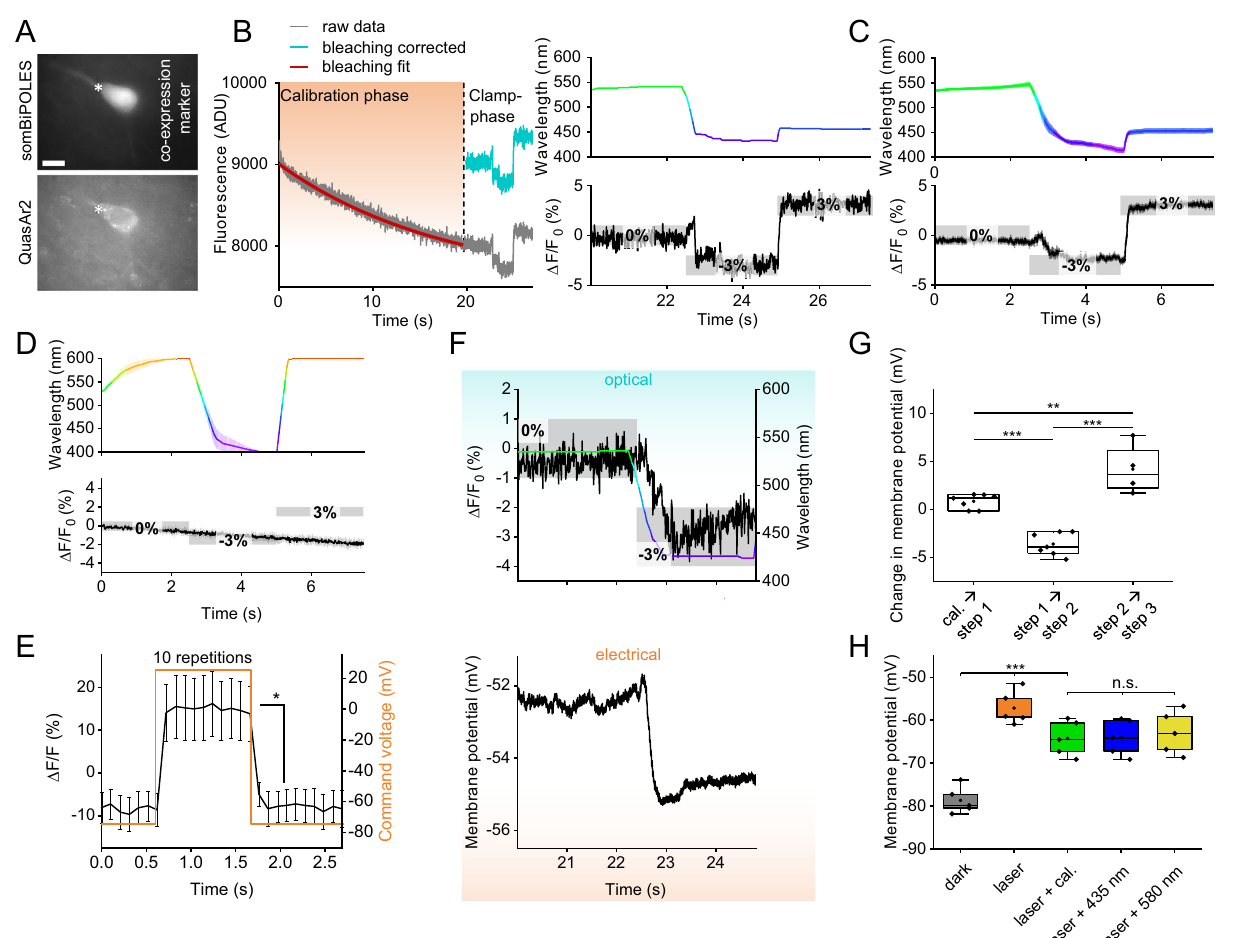
Fig. 5 | Establishing the OVC in rat hippocampal pyramidal neurons. A Fluorescence micrographs of somBiPOLES (CFP co-expression marker) and QuasAr2 expression in a neuron (asterisk). Scale bar: 10 µ m. Representative image (from n =3). B OVC three-step protocol (0, − 3 and 3% Δ F / F 0 ). Right: Wavelength shown in the respective color (upper), holding values and tolerance range (gray boxes, lower panel) are indicated for each step. Left: Orange shade marks transi- tion/calibration period to reach tolerance range. C Overlay of mean (±S.E.M.) wavelength (upper panel) and fl uorescence traces (lower panel; n =12; holding values: 0, − 3, 3% Δ F / F 0 ). D Average fl uorescence data (lower panel) for cells expressingQuasAr2only,whilethe OVCattemptstoruna0, − 3,3% Δ F / F 0 protocol ( n =5; upper panel: Monochromator wavelength). E QuasAr2 fl uorescence during electricallyevoked100mVdepolarizationstep,from − 74.5mVto+25.5mVholding voltage ( n =3, 10 steps analyzed per cell, p =0.046). F Simultaneous patch-clamp